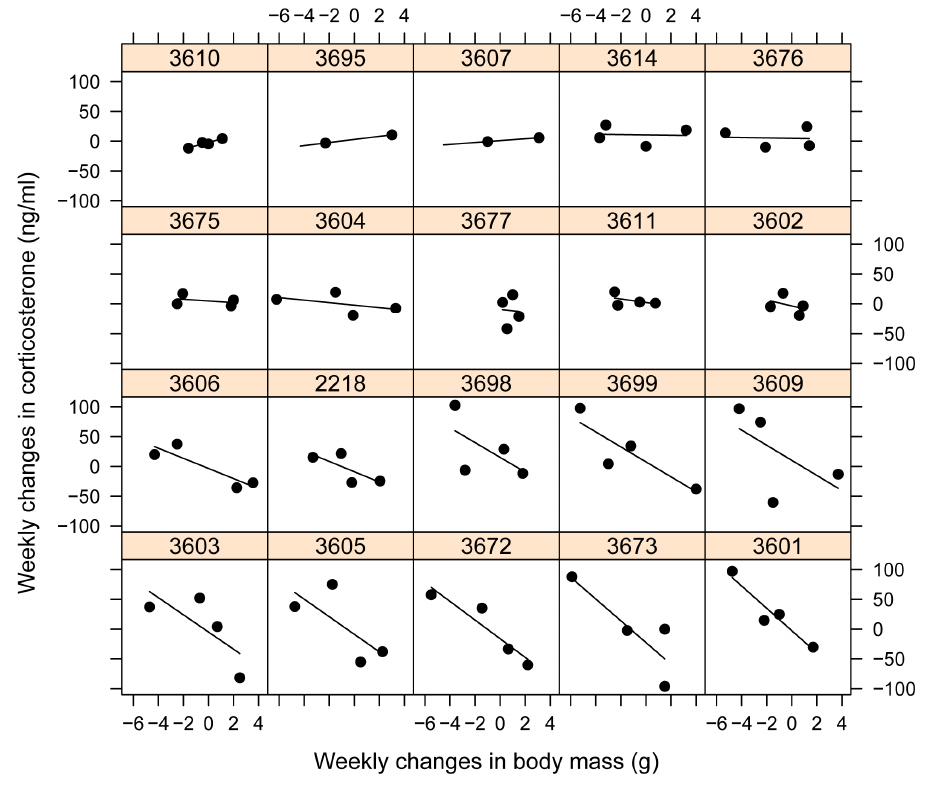
Figure 5. Relationship between the weekly changes in body mass and corticosterone levels in individual house sparrows. Individuals are denoted by their band number above each box. Panels are ordered in function of the individuals’ conditional responsiveness (i.e., the slope of the fitted line), from left to right starting with the top row.